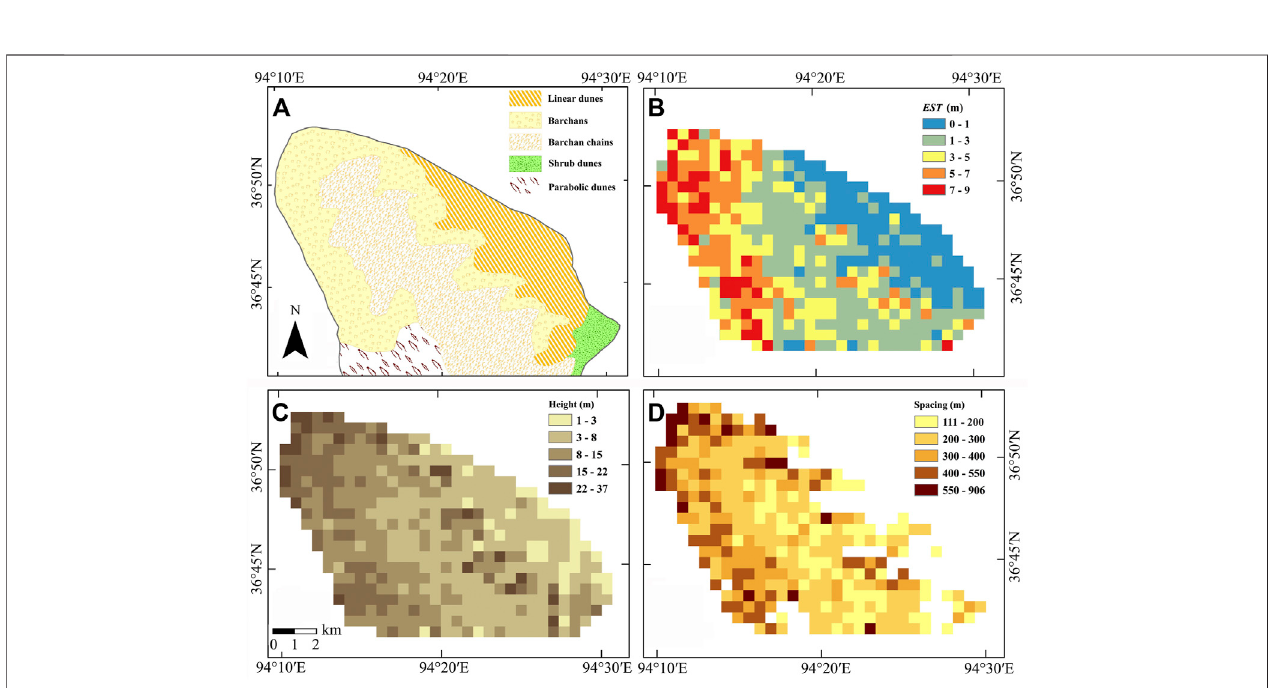
FIGURE 11 | Maps of the (A) dune distribution, (B) equivalent sand thickness ( EST ), (C) dune crest height, and (D) crest to crest dune spacing for area A3 (Figure 1) .